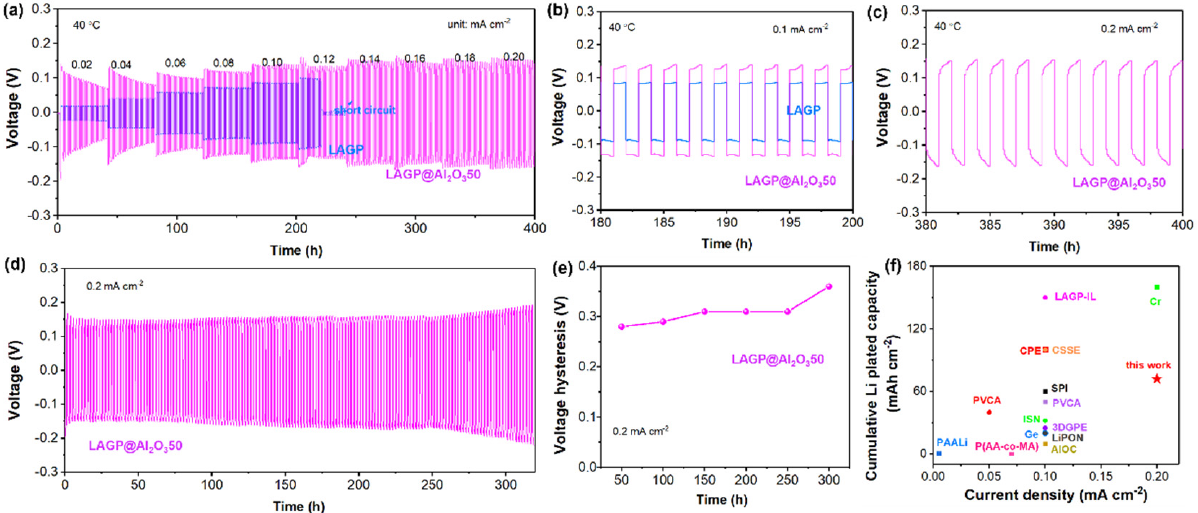
Figure 5. ( a ) Rate performance of symmetrical Li cells with bare and Al 2 O 3 -coated LAGPs as SEs at 0.02–0.2 mA cm -2 at 40 °C, voltage profiles at ( b ) 0.1 and ( c ) 0.2 mA cm -2 , ( d ) long-term cycling per- formance of the Li/LAGP@Al 2 O 3 50/Li cell at 0.2 mA cm -2 (areal capacity: 0.2 mAh cm -2 ) and ( e ) cor- responding voltage hysteresis, ( f ) comparison of cumulative Li plated capacity from this work and literatures. Table 1. Comparison of Li/LAGP/Li cells with interface modification.